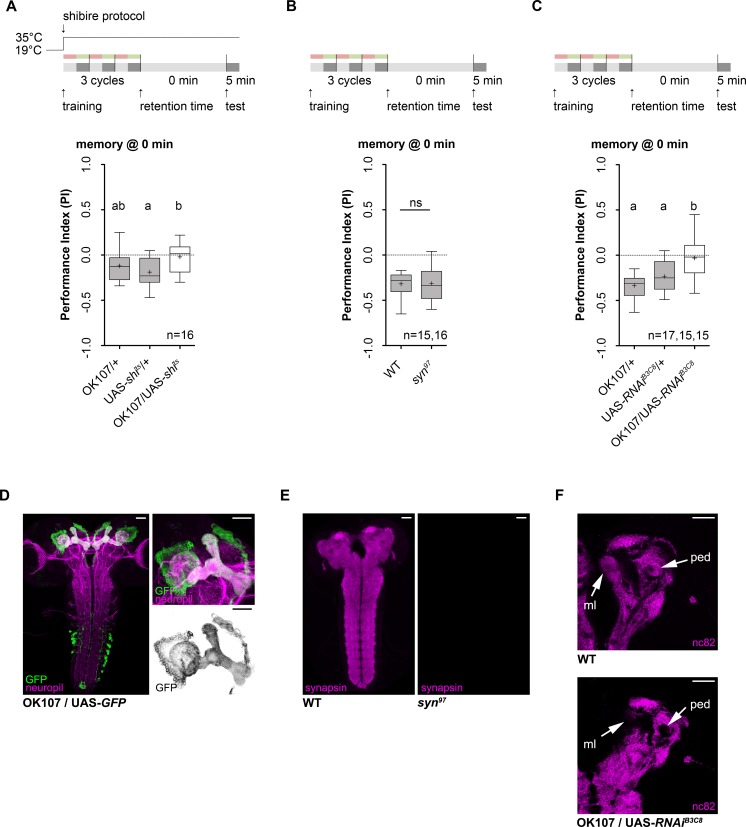
Presynaptic output of mushroom body Kenyon cells is necessary for odor-high salt learning and/or memoryTraining and temperature shift protocols are shown at the top of each panel. A: Effect of the blockade of presynaptic output of MB KCs via UAS-shits1 using OK107-Gal4 driver line on odor-high salt learning and/or memory using three cycle standard training. Larvae were raised at the permissive temperature (19°C) and shifted to restrictive temperature during training and testing. In contrast to both genetic controls that show lARM (One sample t test, p = 0.01 for OK107-Gal4/+, p = 0.0003 for UAS-shits1/+), shits1 expression driven via OK107-Gal4 leads to a complete loss of odor-high salt learning and/or memory tested immediately after three cycle standard training (One sample t test, p = 0.64). Note, only the UAS-shits1/+ control but not the OK107-Gal4/+ control was significantly different from the experimental group UAS-shits1/OK107-Gal4 (Tukey post hoc test, p = 0.018 and p = 0.22, respectively). B: The presynaptic protein Synapsin is not involved in lARM formation. syn97 loss-of-function mutants showed odor-high salt learning and memory (One sample t test, p<0.0001) and behaved non-distinguishable from the genetic control group (Unpaired t test, p = 0.96). C: In contrast to both genetic controls (OK107-Gal4/+ and UAS-brp-RNAiB3C8), knockdown of the presynaptic protein brp in the KCs by driving UAS-brp-RNAiB3C8 via OK107-Gal4 abolishes odor-high salt learning and/or memory (One sample t test, p = 0.56 for OK107-Gal4/UAS-brp-RNAiB3C8, p<0.0001 for OK107-Gal4/+, p<0.0001 for UAS-brp-RNAiB3C8). D: Shows a frontal view projection (left) of a OK107-Gal4/UAS-mCD8::GFP larval brain labeling the entire set of MB KCs (anti-GFP in green and anti-FasII, anti-ChAT neuropil staining in magenta). Additional staining is detectable in the ventral nerve cord (vnc) and neurons that express Drosophila insulin-like proteins (dilp). On the upper right panel a zoom in of the MB is shown. On the lower right panel only the GFP channel is depicted. Scale bars: left panels 50μm, right panels 25μm. E: Shows frontal view projections of a wild type brain (left panel) or the syn97 loss-of-function mutant (right panel) stained with anti-synapsin (magenta). As reported, anti-synapsin was only detected in the wild type brain but completely absent in the syn97 loss-of-function mutant. Scale bars: 50μm. F: Shows a single section of a frontal view of brain hemispheres of a wild type (left panel) and an experimental larva (right panel) using anti-nc82 to recognize Brp. In contrast to wild type larvae, no anti-nc82 staining was detectable in the MB (shown at the peduncle and the medial lobe level by arrows). Scale bars: 25μm. Differences between groups are depicted above the respective box plots, ns indicates p≥0.05. Different lowercase letters indicate statistical significant differences from each other at level p<0.05. Grey boxes show memory performance above chance level (p<0.05), white boxes indicate random distribution (p≥0.05). Small circles indicate outliers. Sample size is n = 16 for each group if not indicated otherwise